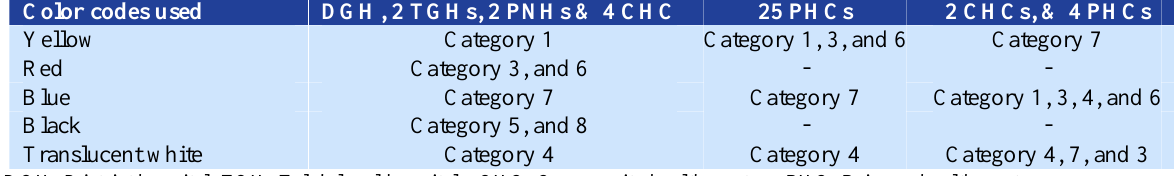
Table 2. Color codes used for segregation and collection of health care wastes generated in different level hospitals in the